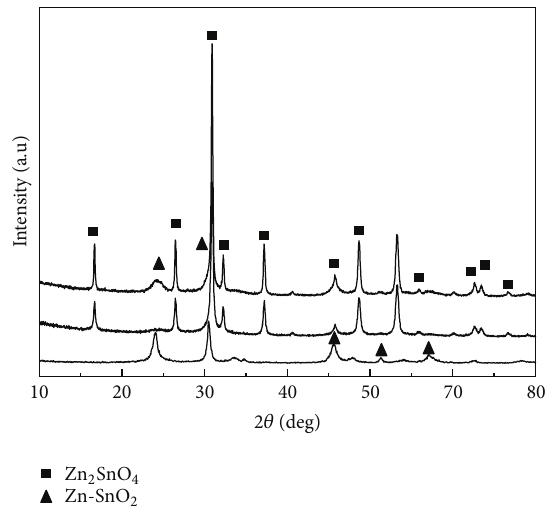
Figure 1: XRD patterns of as-prepared Zn-doped SnO 2 , Zn 2 SnO 4 , and Zn-doped SnO 2 /Zn 2 SnO 4